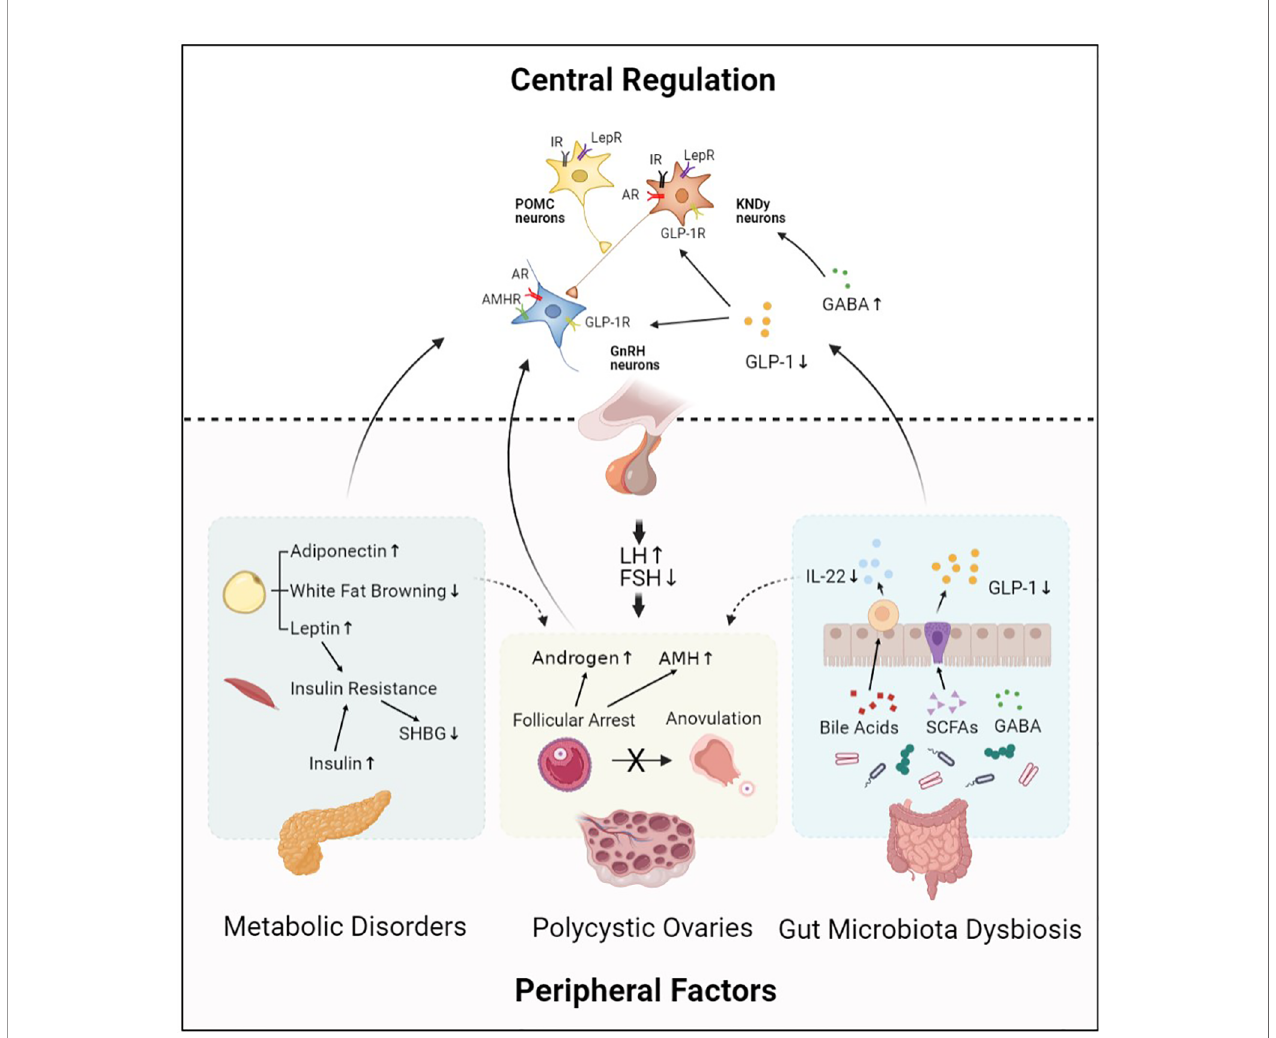
FIGURE 1 | Central regulation of PCOS. Hypothalamic GnRH pulse mediates regulation of LH and FSH synthesis, which plays an important role in PCOS pathophysiology. This process is modulated by central regulators including KNDy neurons, POMC neurons, and neurotransmitters. In addition, peripheral factors including abnormal ovarian hormone levels, metabolic disorders, and gut microbiota dysbiosis also contribute to PCOS development by acting on their receptors expressed in hypothalamic neurons. Moreover, central regulators and peripheral factors interact with each other and form an abnormal neuronal – reproductive – metabolic circuit, thus promoting PCOS development. GnRH, Gonadotropin-releasing hormone; KNDy neurons, kisspeptin/NKB/dynorphin A neurons; POMC neurons, Pro-opiomelanocortin neurons; GABA, g -aminobutyric acid; GLP-1, Glucagon-like peptide-1; IR, Insulin receptor; LepR, Leptin receptor; AR, Androgen receptor; GLP-1R, Glucagon-like peptide-1 receptor; AMHR, Anti-Müllerian hormone receptor; LH, Luteinizing hormone; FSH, Follicle stimulating hormone; AMH, Anti-Müllerian hormone; SHBG, Sex hormone-binding globulin; IL-22, Interleukin 22; SCFAs, Short-chain fatty